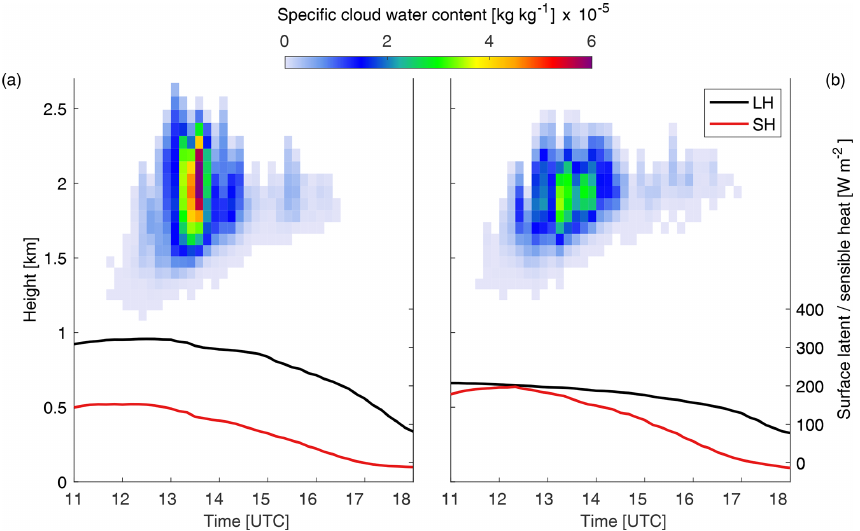
Figure 8. ICON-LEM specific cloud water content for the ICON1 (a) and ICON2 (b) simulation together with the surface fluxes of latent and sensible heat. The results are averaged for the domain shown in Fig.